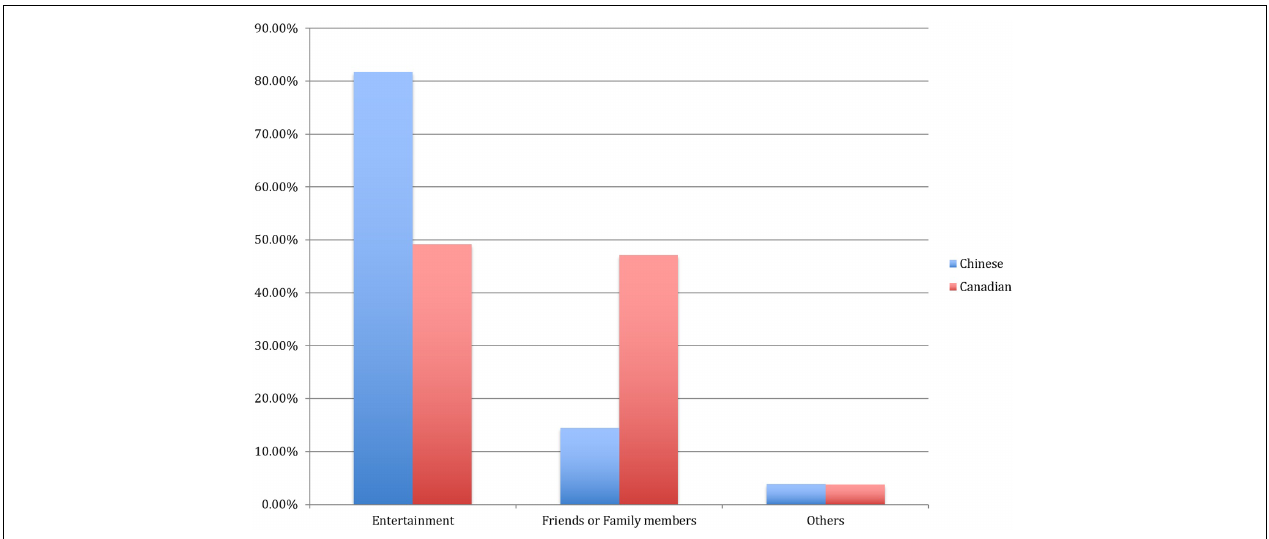
FIGURE 3 | The percentages of nominated humorists by Chinese and Canadian